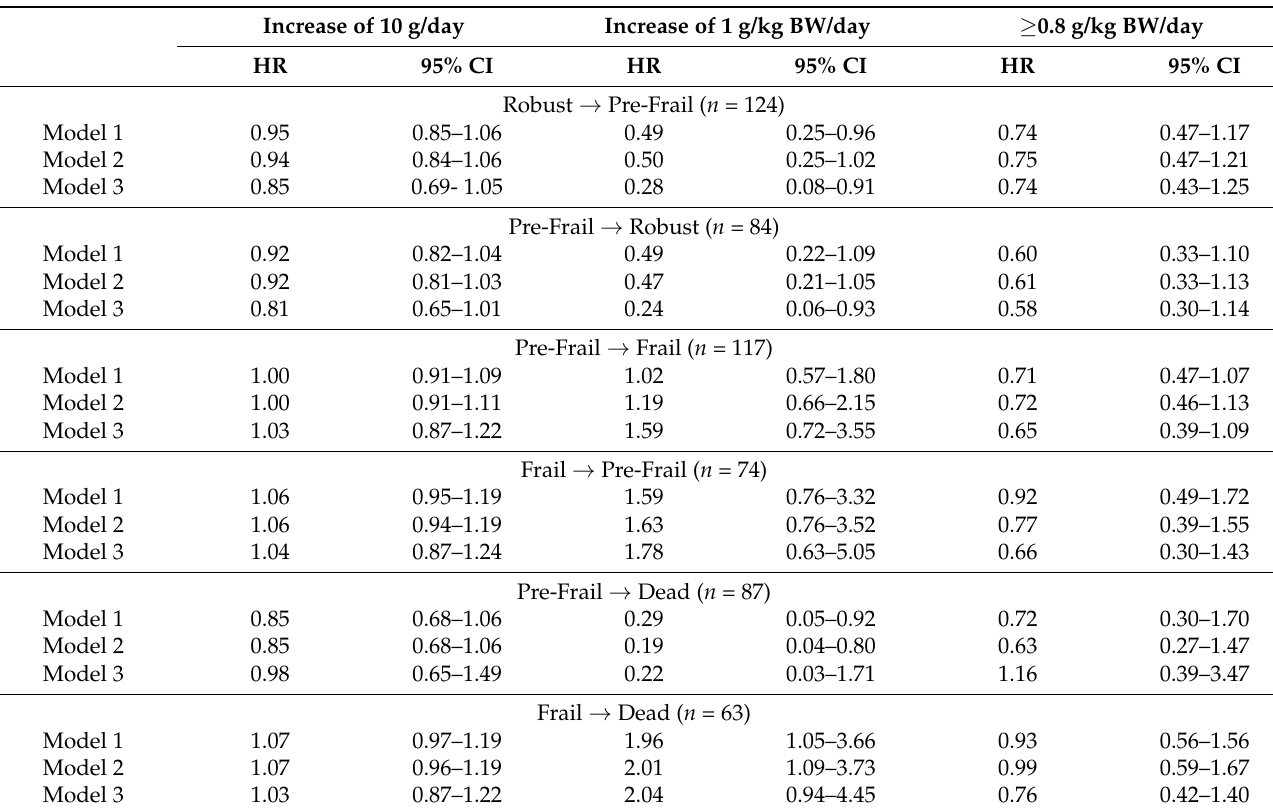
Table 3. Hazard ratios and 95% confidence intervals for the association between protein intake and transitions between frailty states and to death over four